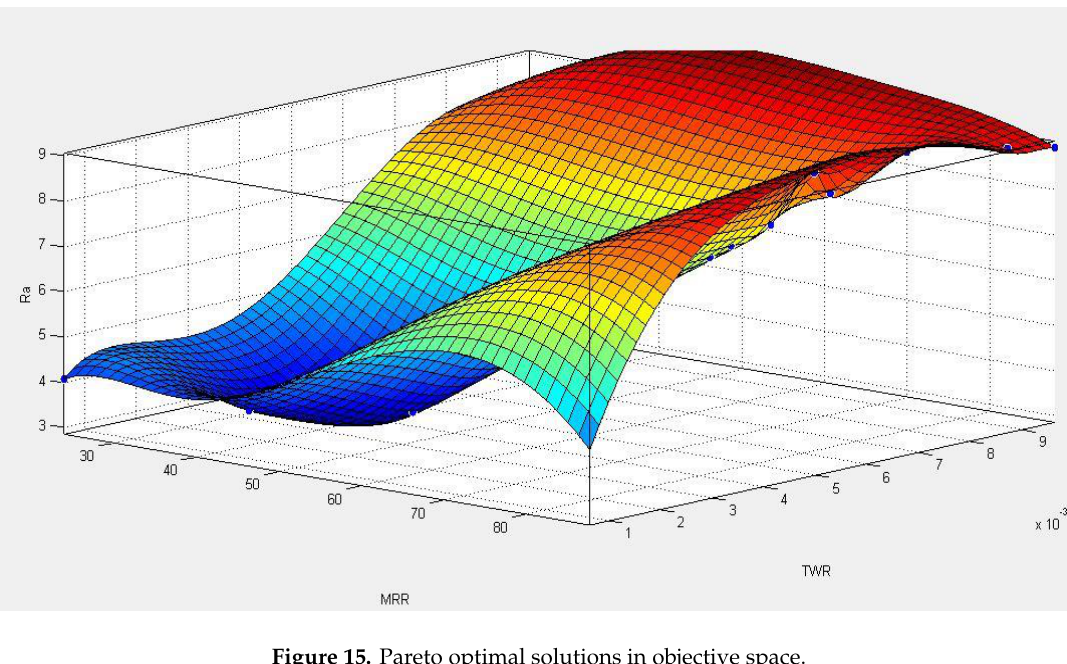
Figure 15. Pareto optimal solutions in objective space. Mathematics 2019 , 7 , x FOR PEER REVIEW